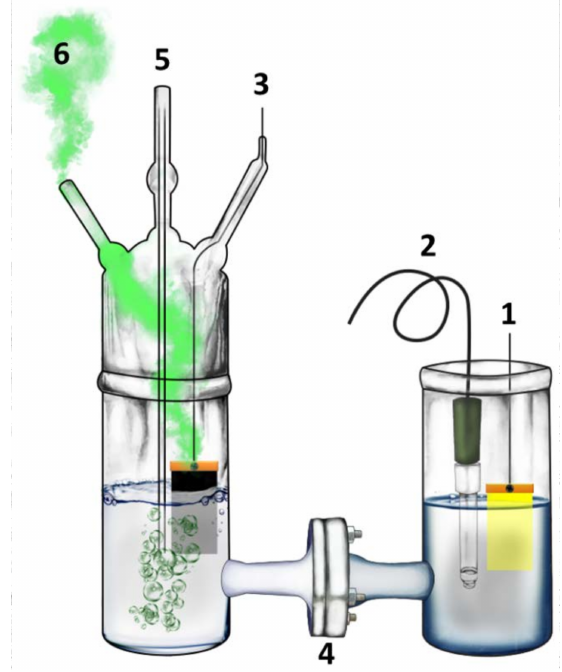
Figure 1. Graphical design of the employed reactor: (1) photoanode; (2) reference electrode; (3) counter electrode; (4) ion transfer membrane; (5) tube for the introduction of Ar; and (6) exhaust of Ar mixed with H 2